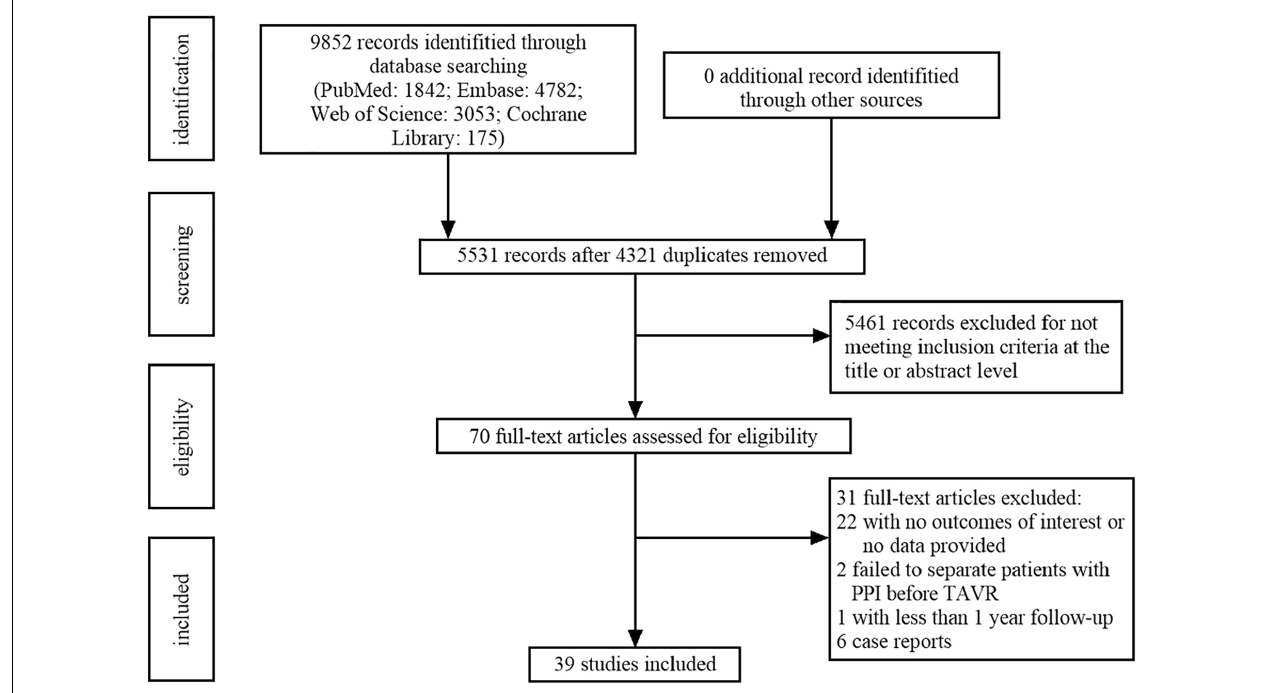
FIGURE 1 | Flowchart of study selection based on the Preferred Reported Items for Systematic Reviews and Meta-Analysis (PRISMA) statement.